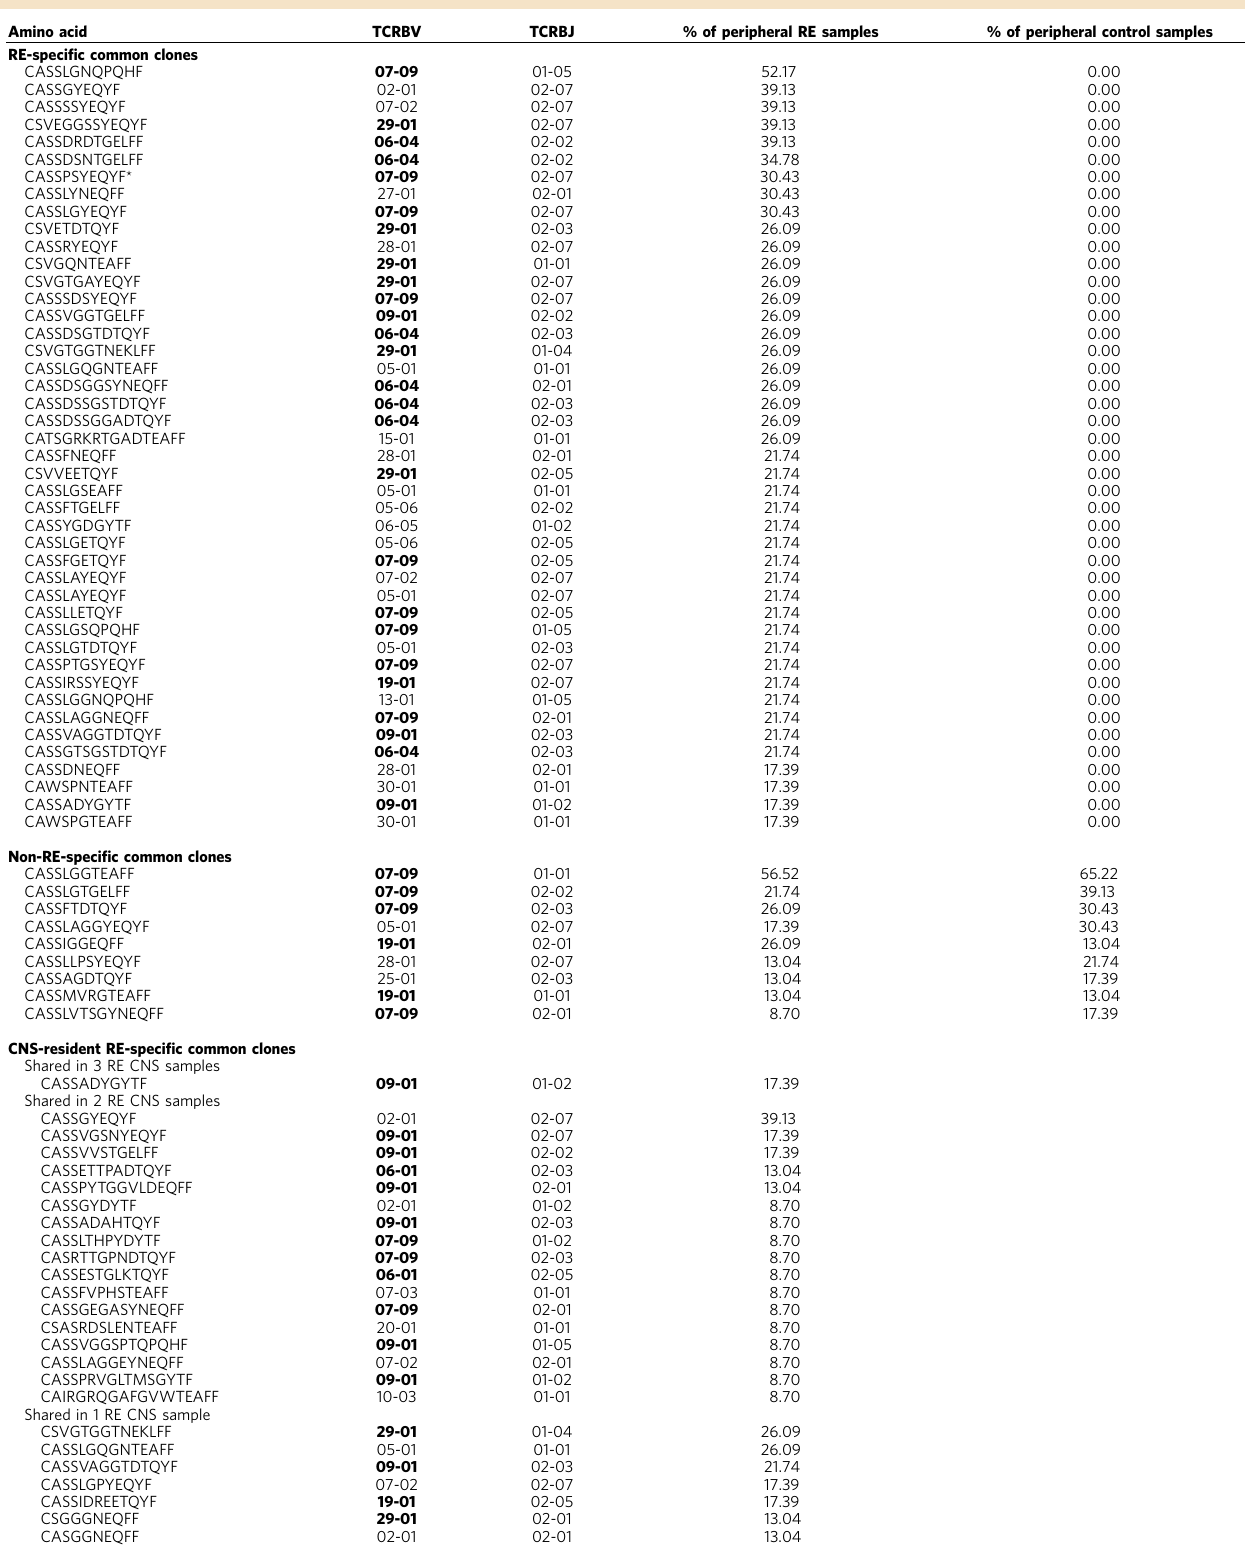
Table 2 | Sequence detail of T-cell clones shared between CNS and peripheral blood. Amino